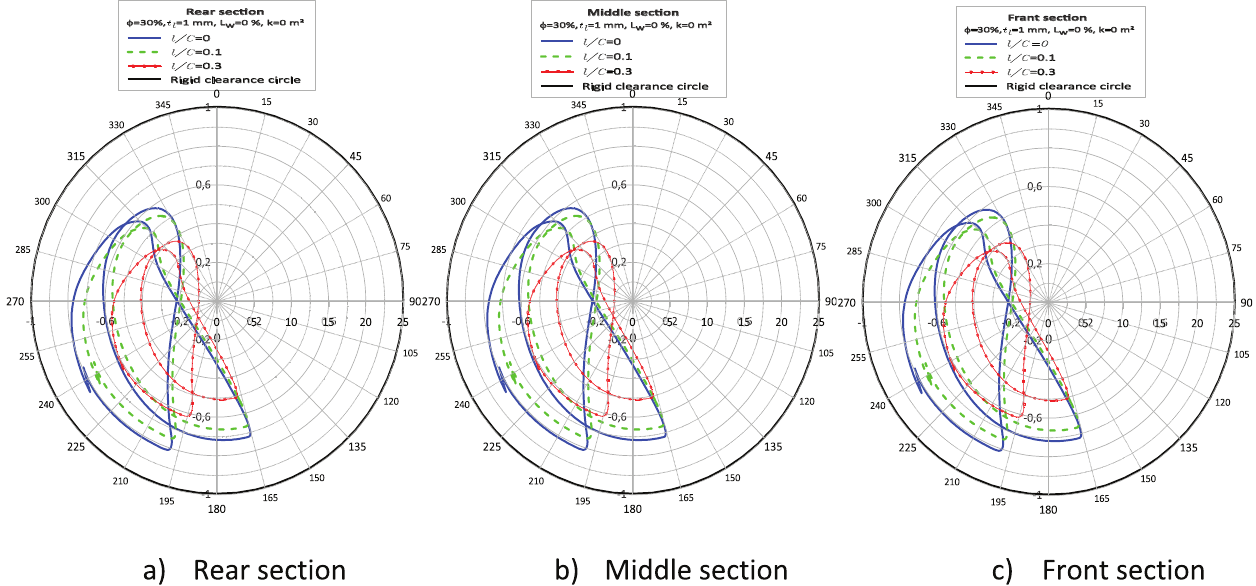
Fig. 15. Effects of the particle size parameter, l / C , on the stationary Journal center orbits for the deformable case.